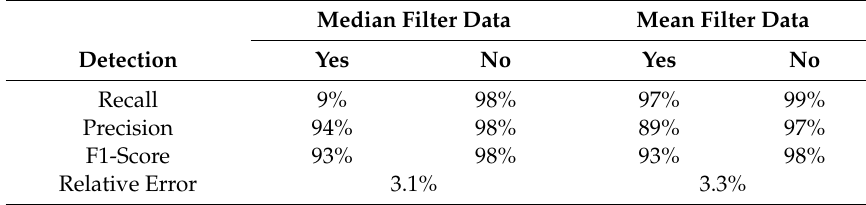
Table 6. Classification results for the training dataset.